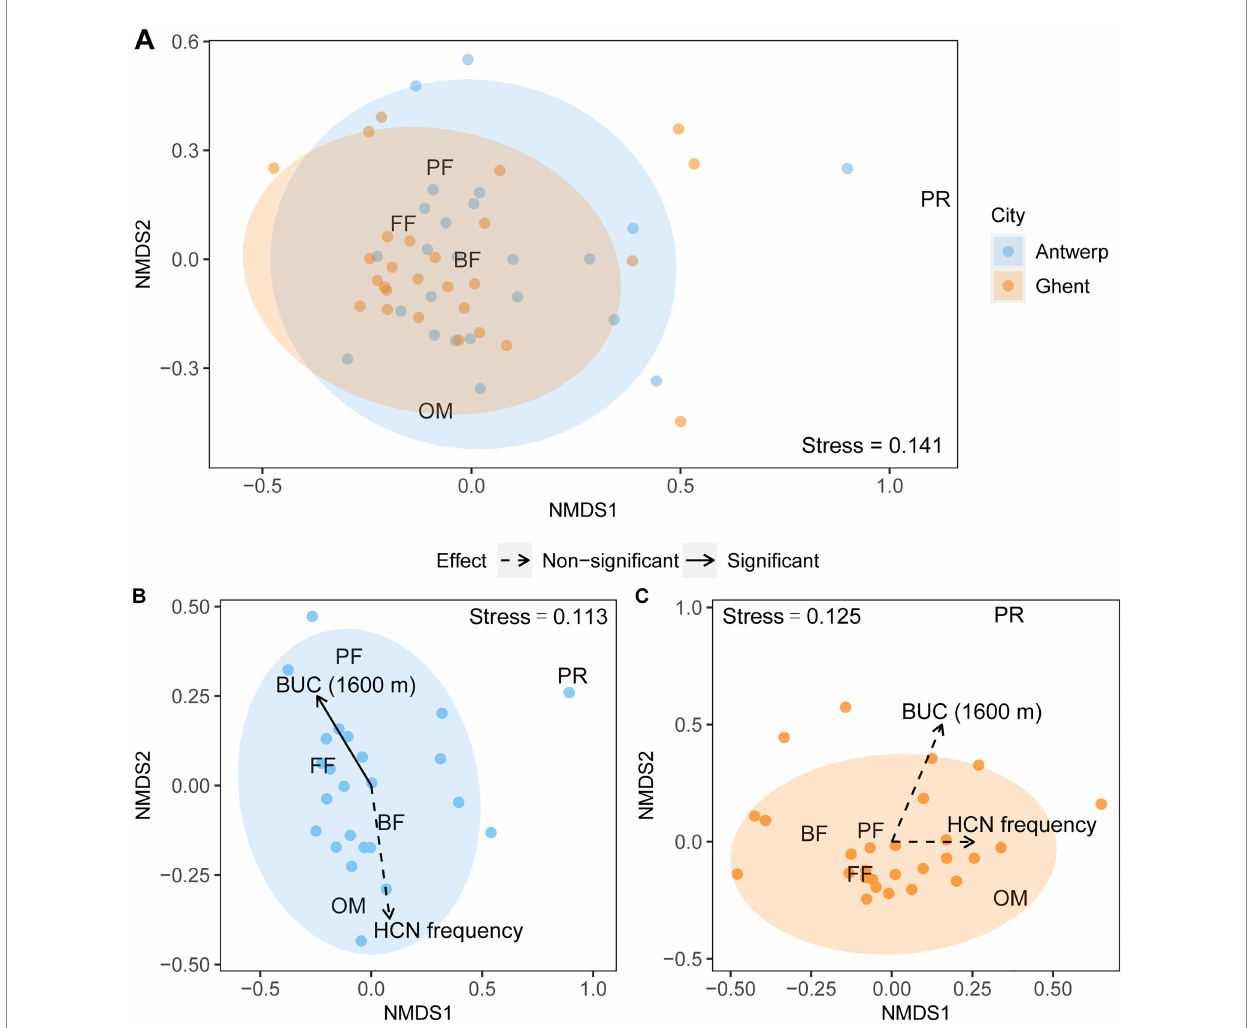
FIGURE 4 Nematode feeding-guild composition in the roots of Trifolium repens across the cities of Antwerp and Ghent and environmental factors for each of them. (A) Non-metric multidimensional scaling (NMDS) plot showing compositional difference of nematode feeding guilds between Antwerp and Ghent. Explanatory variables of urbanization gradient (BUC) within the radius of 1,600 meter and frequency of HCN production (HCN frequency) are superimposed for Antwerp (B) and Ghent (C) . Sample size for Antwerp and Ghent is 24 and 27, respectively. Nematode feeding guilds are bacterial feeders (BF), fungal feeders (FF), plant feeders (PF), predators (PR) and omnivores (OM). Effects of both environmental variables on the nematode community composition were evaluated by PERMANOVA (Supplementary Table S3), and significant and non-significant effects are indicated in solid and dashed lines, respectively. The stress levels of NMDS 2D plots are